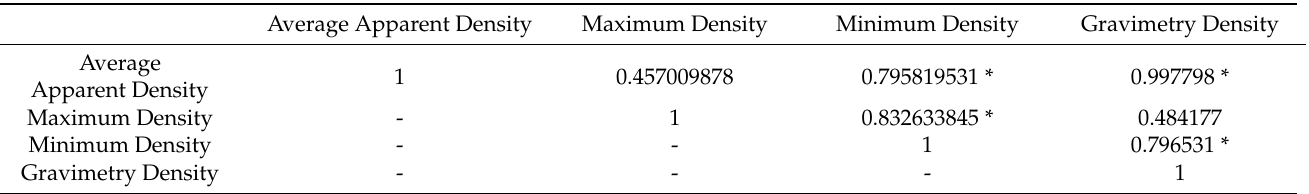
Table 7. Pearson correlations of results obtained by X-ray densitometry of panels manufactured by hot